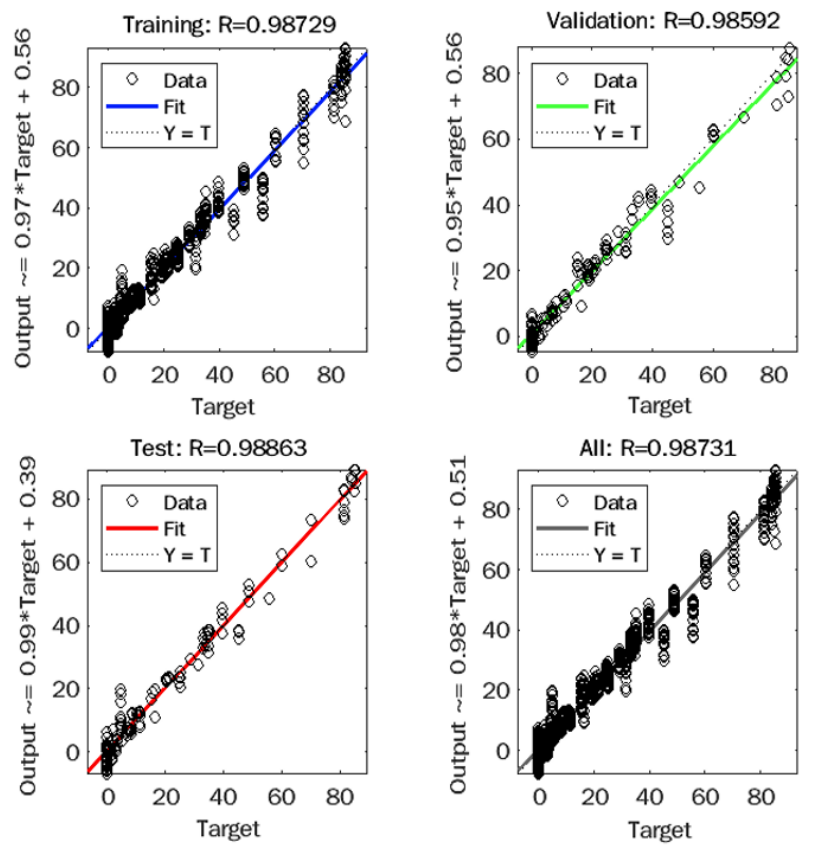
Figure 14. Observed versus predicted plot for R 3.2 of RTFO binders.